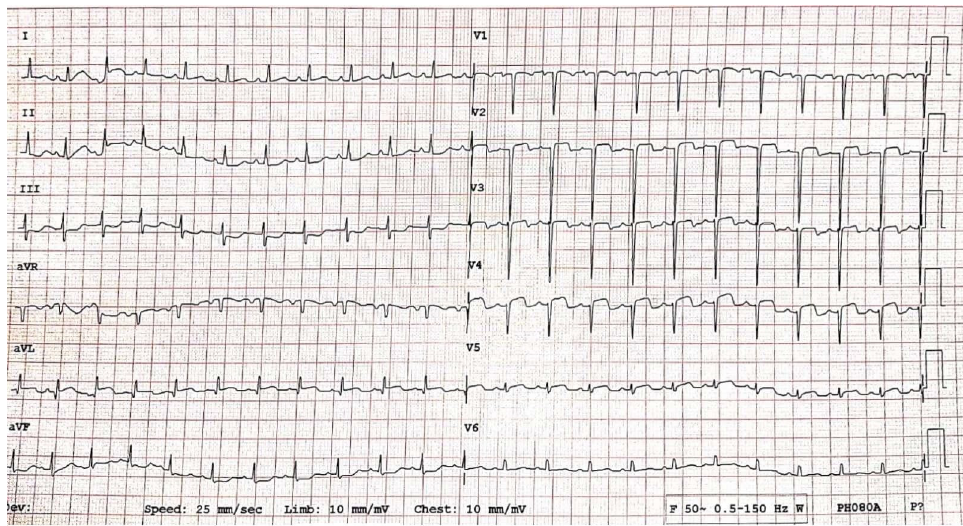
Figure 6. Electrocardiogram after thrombolysis, criteria of reperfusion. Subsequent echocardiographic evaluations demonstrated a slow enhancement of the cardiac function, with maintenance of the dyskinetic movement of the LV apex. We couldn’t achieve the complete resolution of the thrombus initially. An attached mobile thrombus was visible for a couple of days, with interesting imaging revealing a secondary, larger aneurysm of the ADA of 10 × 8 mm, z score +24 after reperfusion and opening of the first one with an acceptable blood flow at the level of ADA and LCX. During his hospital stay, the patient experienced one dermatological complication with uncertain etiology, two zones of alopecia areata (Figure 7). Alopecia areata appeared either due to stress exposure, as an adverse effect to ACE inhibitor, or triggered by coro- nary artery abnormalities [26–29]. We changed the lisinopril (ACE inhibitor) to losartan (angiotensin receptor blocker) and associated a local treatment according to the dermatol- ogist’s recommendation, with a favorable local evolution. Figure 7. Alopecia areata, a complication during myocardial infarction recovery possibly related to the ACE inhibitors treatment. Subsequent evaluations after discharge (at 1 month) revealed the presence of the thrombus inside the second aneurysm of the ADA and increased CK-MB (37 U/L, NV <